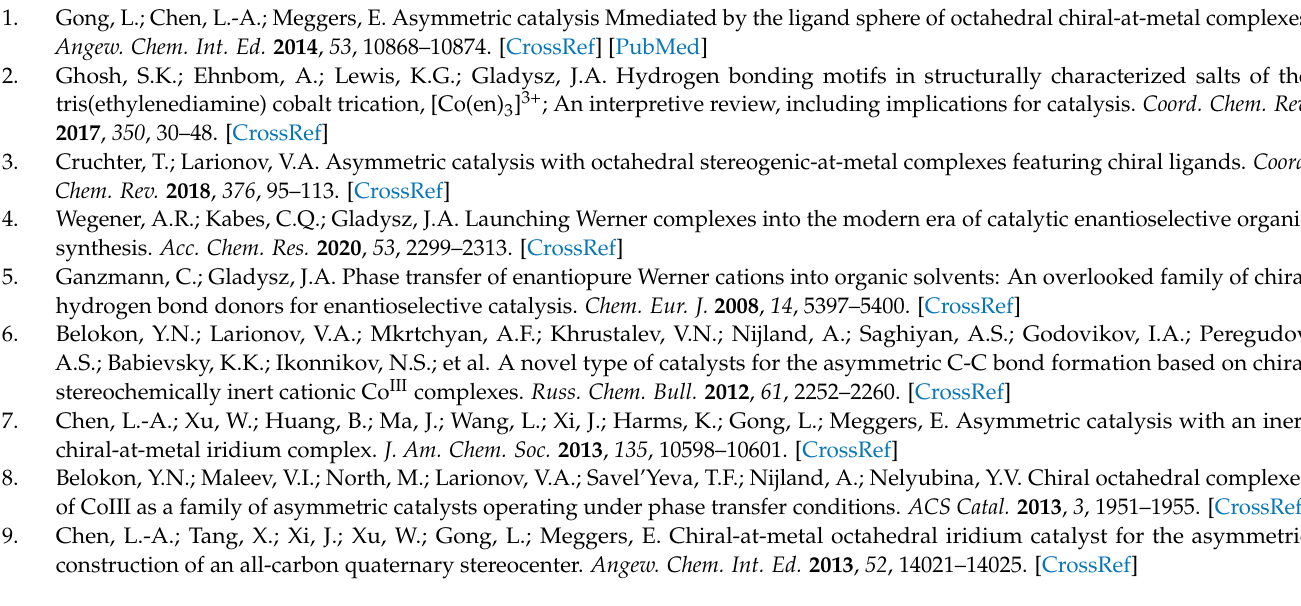
Figure S4: UV-vis spectrum of the complex Λ ( R , R )- 2 recorded in CH 2 Cl 2 ; Figure S5: X-ray structure of the Co(III) complex 2 of ∆ -configuration with co-crystallized acetonitrile molecules; Table S1: Crystallographic data for the complex 2 ; Table S2: Selected bond distances and angles for the